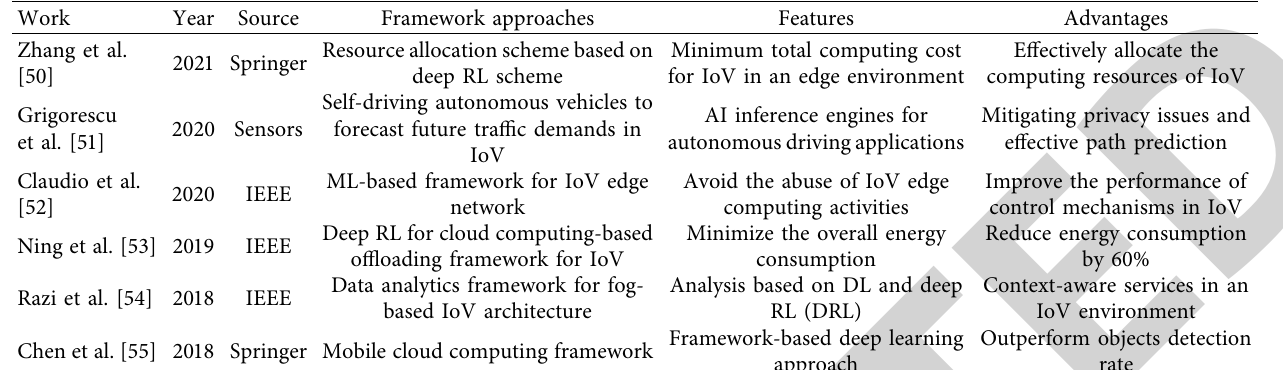
Table 2: Summary of AI applications for cloud-based IoV